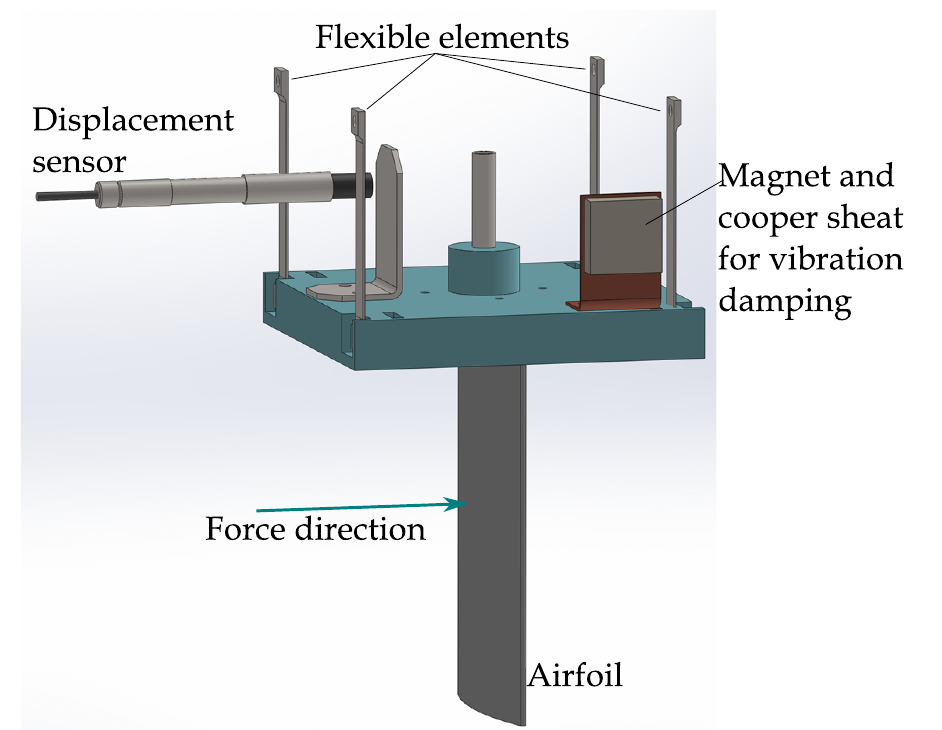
Figure 8. Sketch and photograph of the balance used for lift force measurement. The metallic flexible elements are connected to the wind tunnel walls at their upper end. The airfoil is reinforced by using an aluminum tube, which connects the airfoil to the movable table as well. The eddy-current sensor is used to electrically measure the displacement of the entire table.